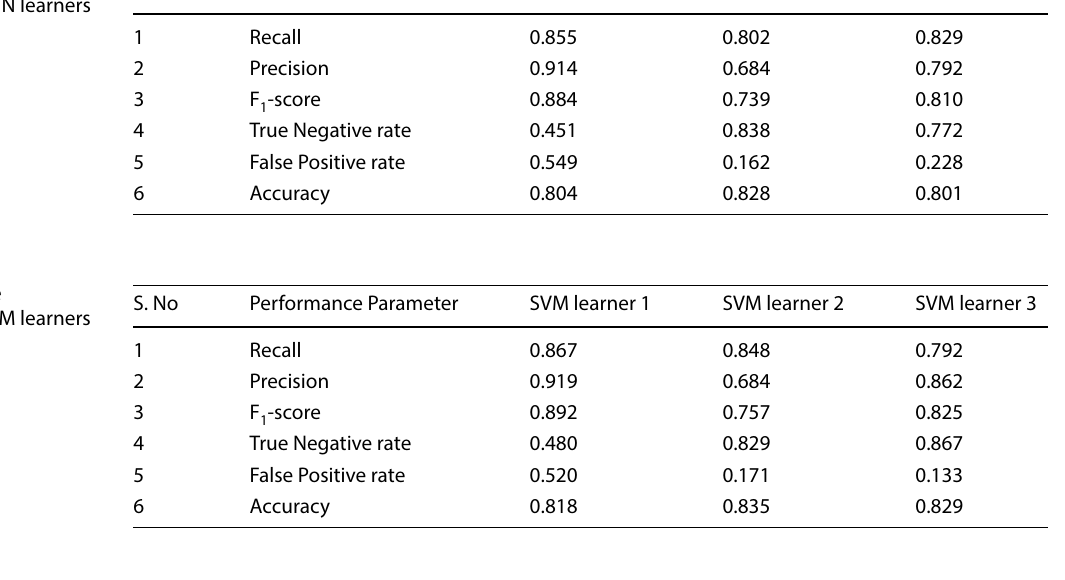
Table 6 Performance parameters of the KNN learners